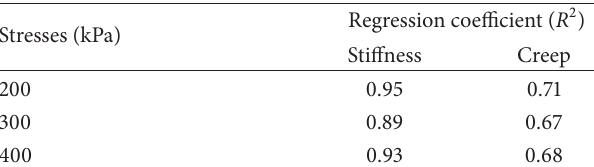
Table 9: Regression coefficient between fatigue strain and creep strain and stiffness using SPSS